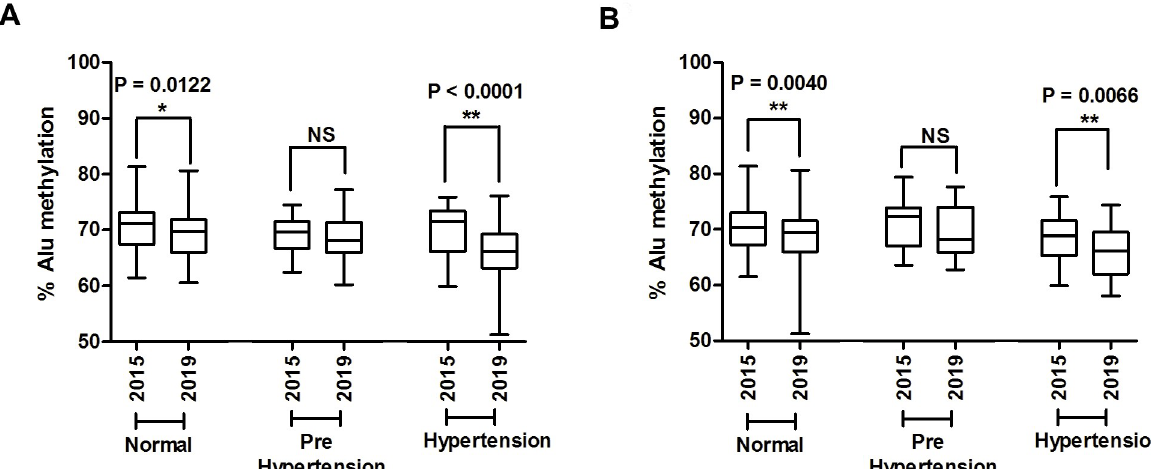
Fig 5. Alu methylation levels over 4 years (2015–2019) of follow up in the same person from the normal, prehypertension, and hypertension groups categorized based on the systolic pressure (A) and diastolic pressure indicators (B). � P < 0.05, �� P < 0.01 (Paired t -test).